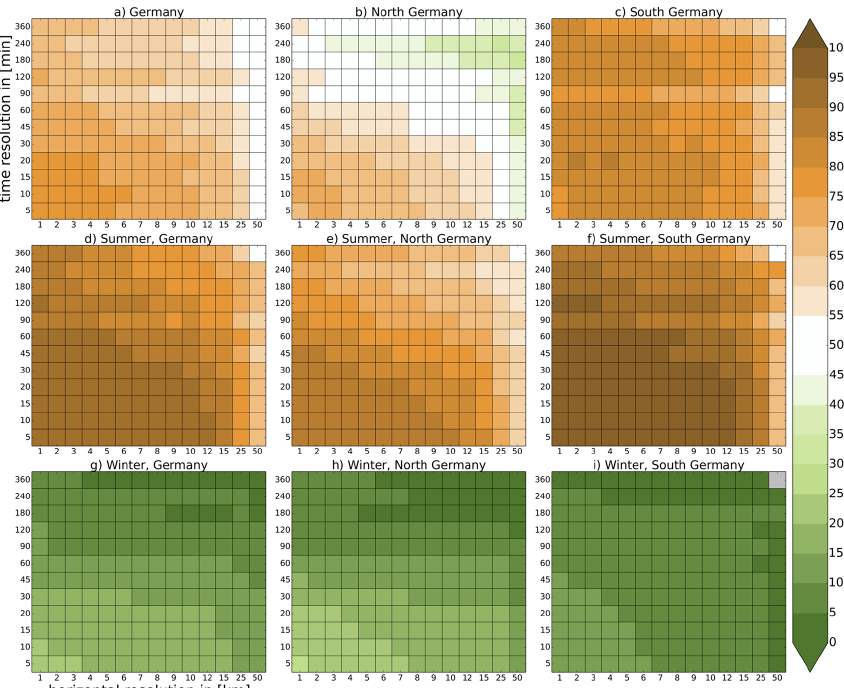
Figure 8. Convective dominance as a function of resolution including dry periods. The ratio of the number of convective precipitation events with precipitation intensities greater than or equal to the threshold intensity. Threshold intensity is defined as the 99th percentile of total precipitation intensities over the different parts of Germany for the years 2007–2008. Panels otherwise as in Fig. 3.